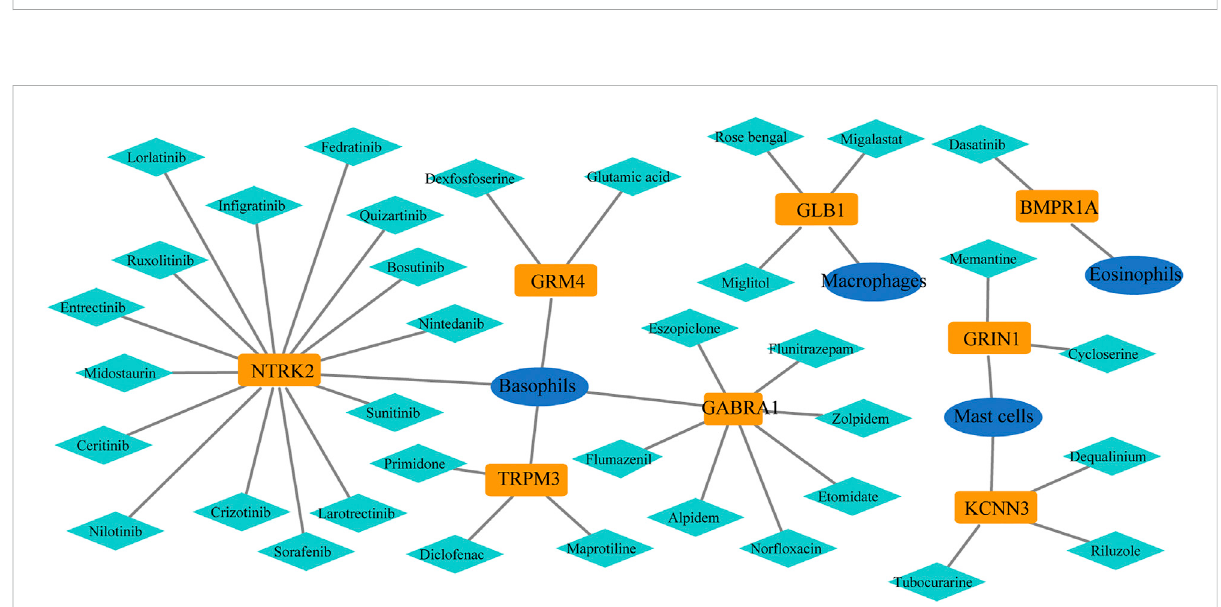
FIGURE 9 Potential drugs of selected genes from the PharmGKB database: 36 drugs targeted these eight